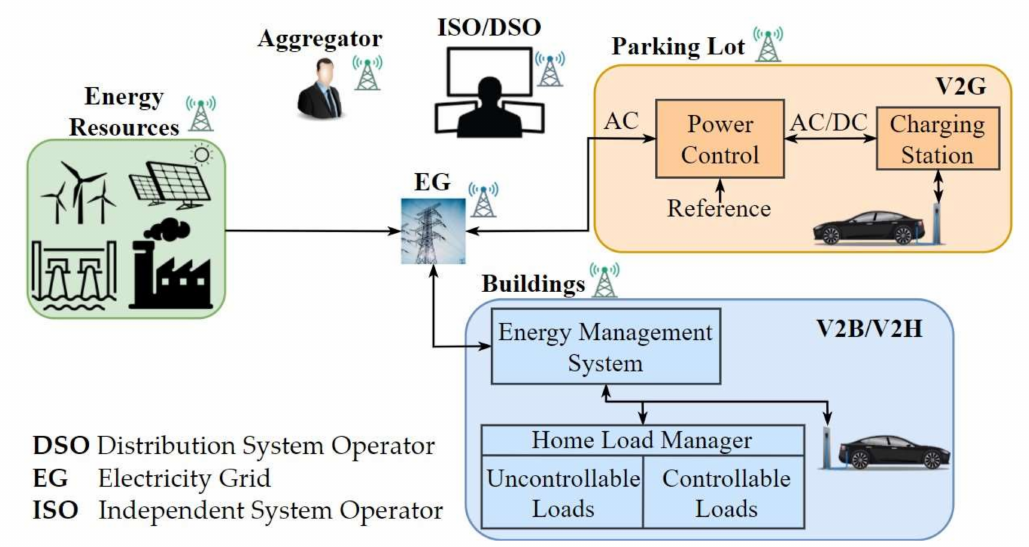
Figure 1. Proposed Vehicle-to-Everything